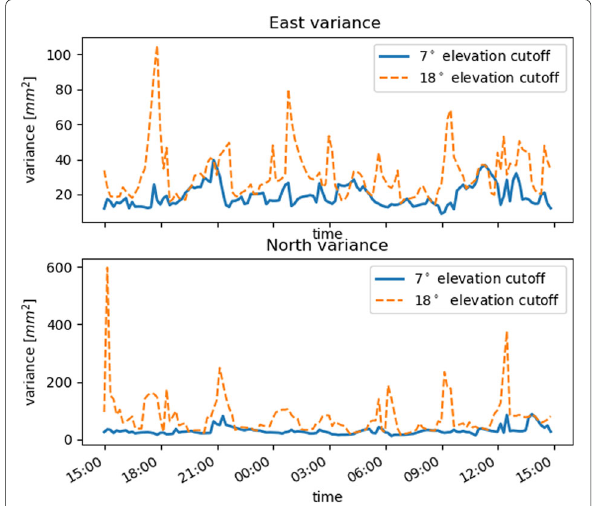
Fig. 19 RTK localization error variance obtained at Loc1 for open-sky and urban scenario modeled with elevation cutoff angles 7 ◦ and 18 ◦ , respectively